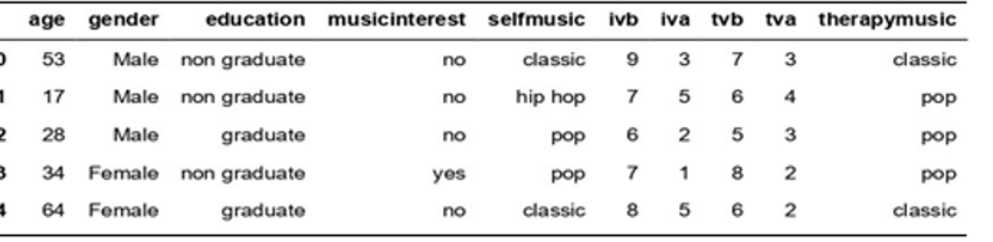
Figure 2. Sample Instances of the Dataset